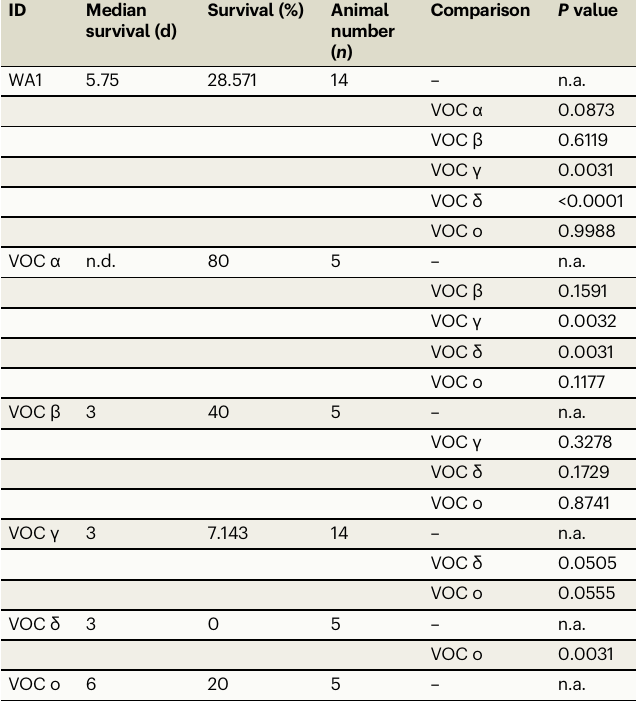
Table 1 | Analysis of dwarf hamster survival after infection with different VOC ID Median survival